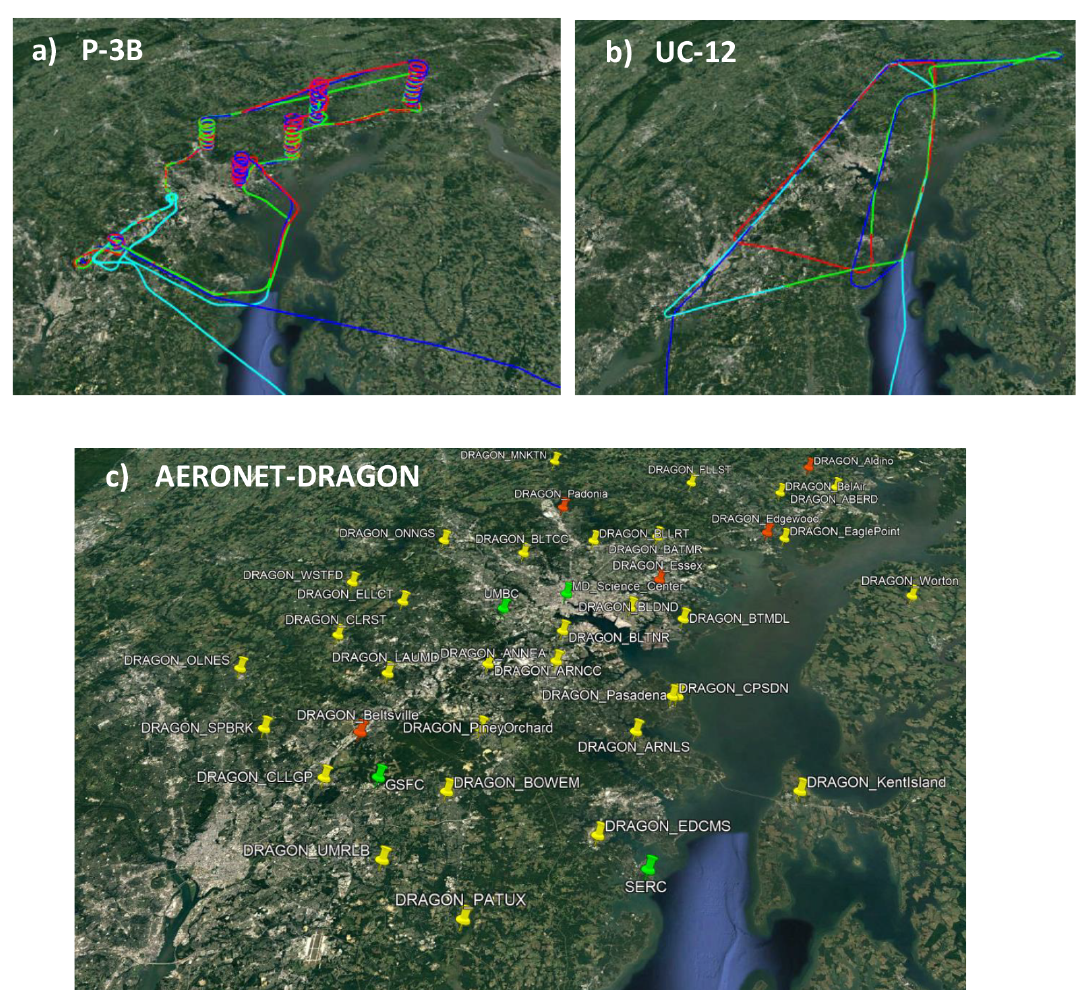
Figure 1. For 29 July 2011: (a) flight track for P-3B airplane, (b) flight track for the UC-12 airplane and (c) AERONET-DRAGON stations. The region is the Baltimore–Washington DC area, covering approximately from 38.75 to 39.75 ◦ N and from 77.75 to 75.25 ◦ W. Maps attribution are Google Landsat/Copernicus Data SIO, NOAA, US Navy, GEBCO. Data LDEO-Columbia, NSF,